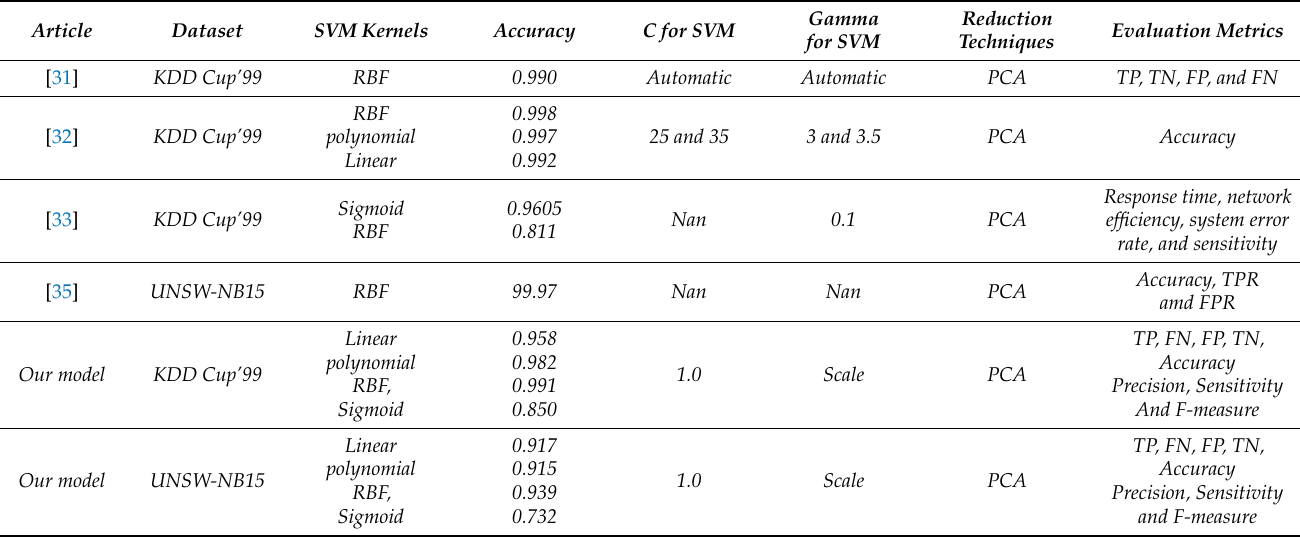
Table 3. Summary of the previous